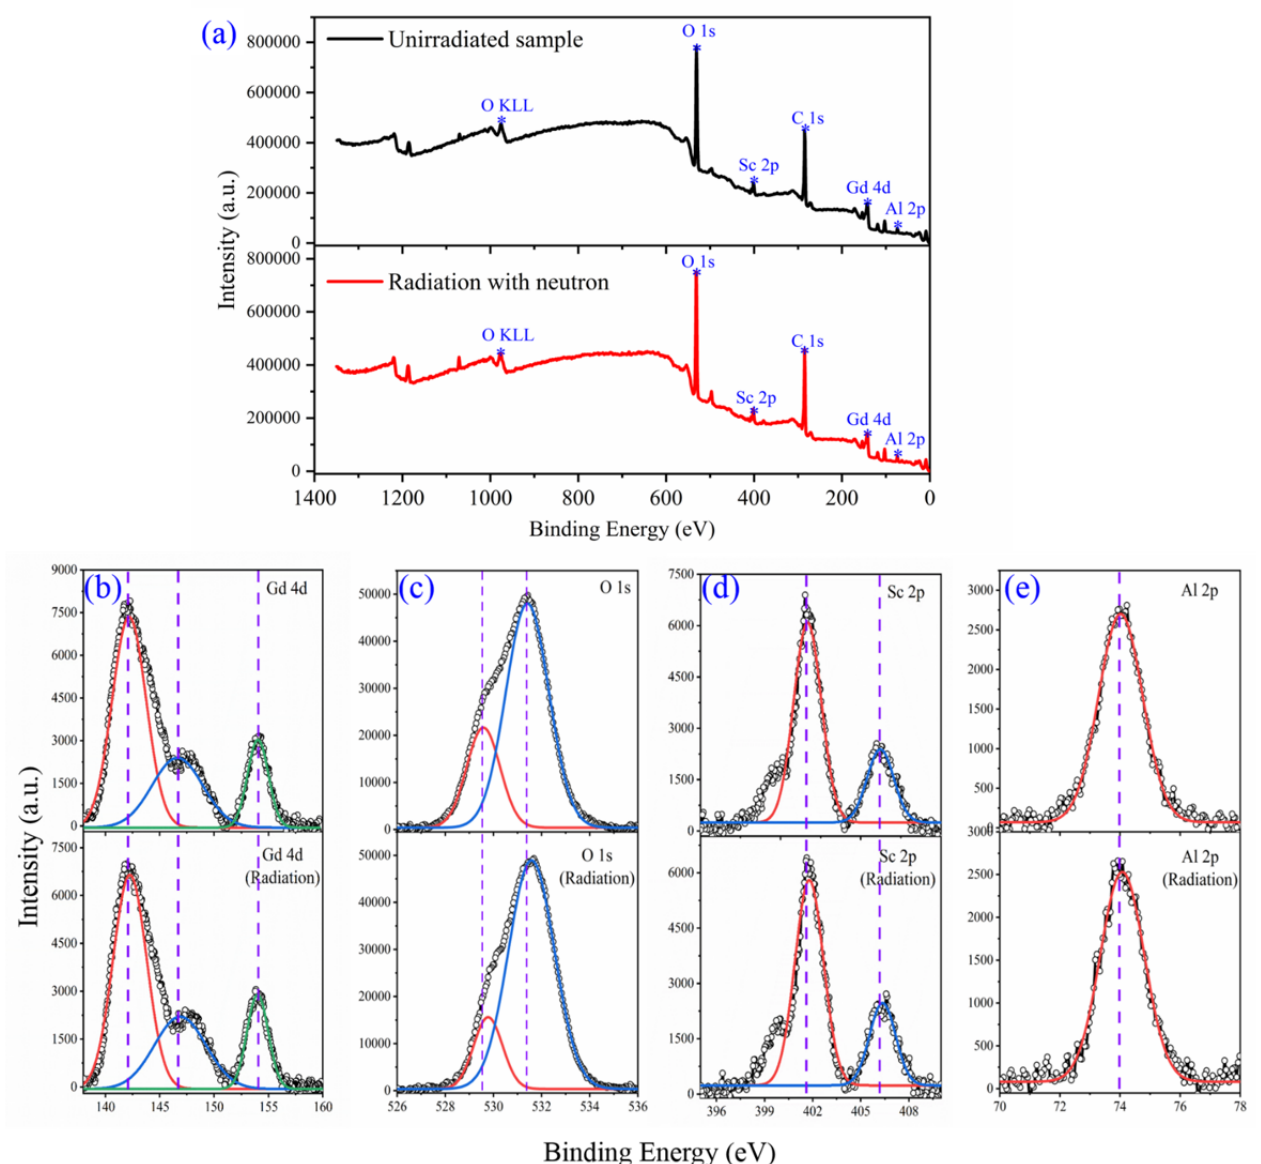
Figure 3. ( a ) The room temperature typical X-ray photoemission spectra (XPS) of Nd:GSAG crystal before and after irradiation with neutrons. ( a ) XPS survey spectra; ( b ) XPS spectra of Gd 4d core levels; ( c ) XPS spectra of O 1s core levels; ( d ) XPS spectra of Sc 2p core levels; ( e ) XPS spectra of Al 2p core levels.